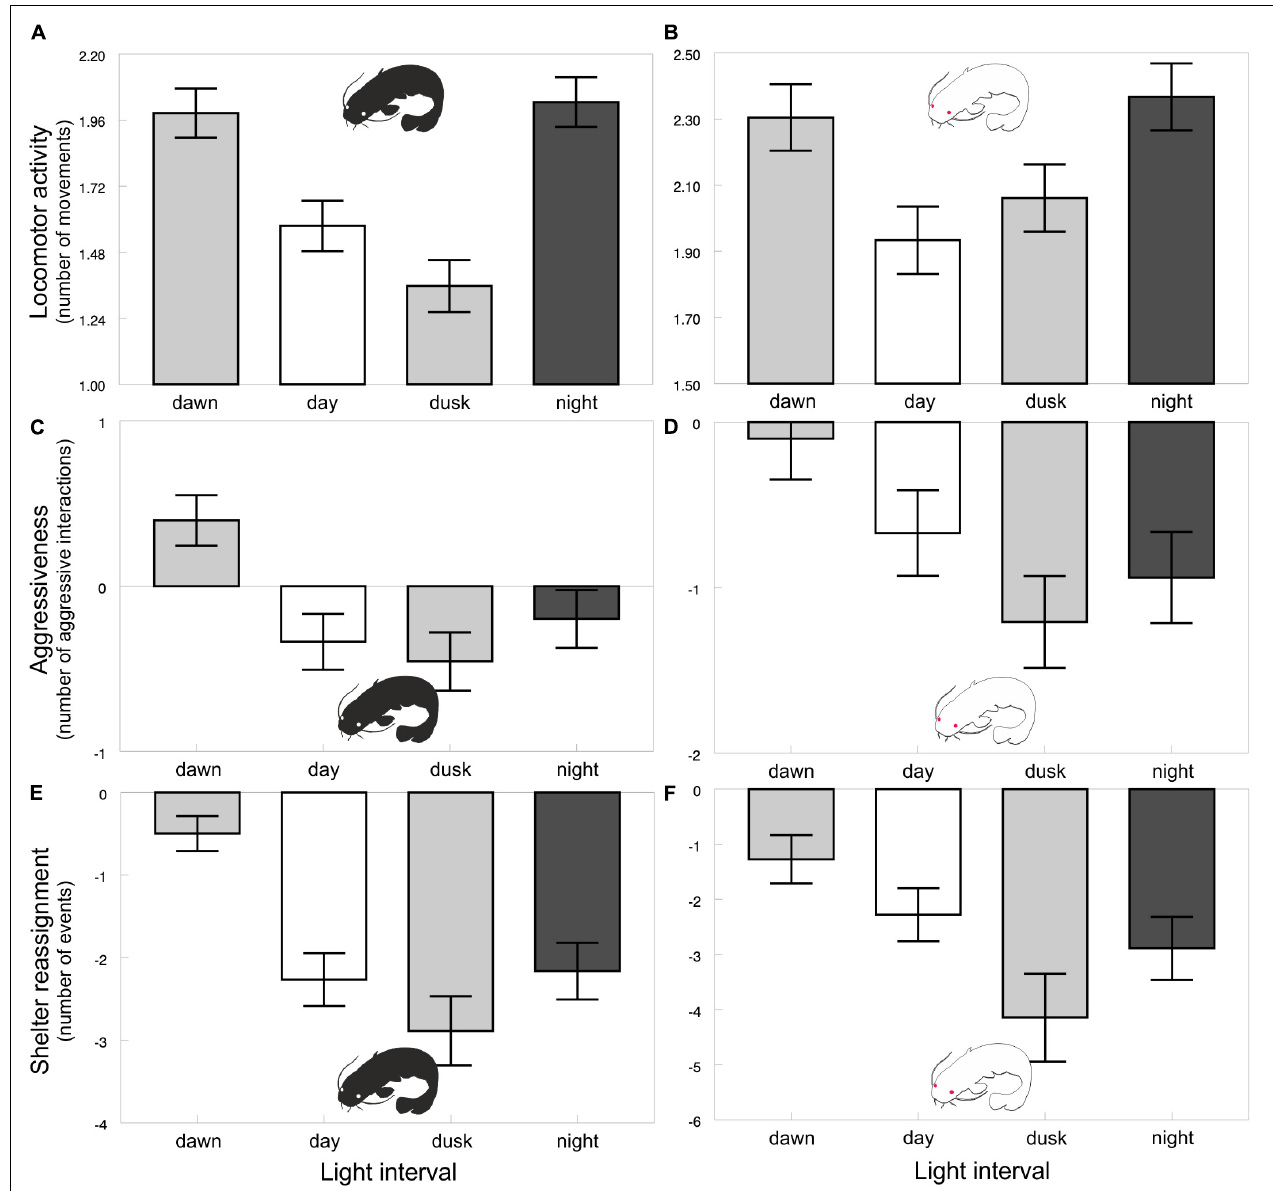
FIGURE 3 | Locomotor activity of pigmented (A) and albino (B) catfish, aggressiveness of pigmented (C) and albino (D) catfish and shelter reassignment of pigmented (E) and albino (F) catfish in the arena with a shelter across light intervals. Values ( ± SEs) of behavioral indices are predicted from the mixed models (i.e., presented data are after the adjustment by the statistical